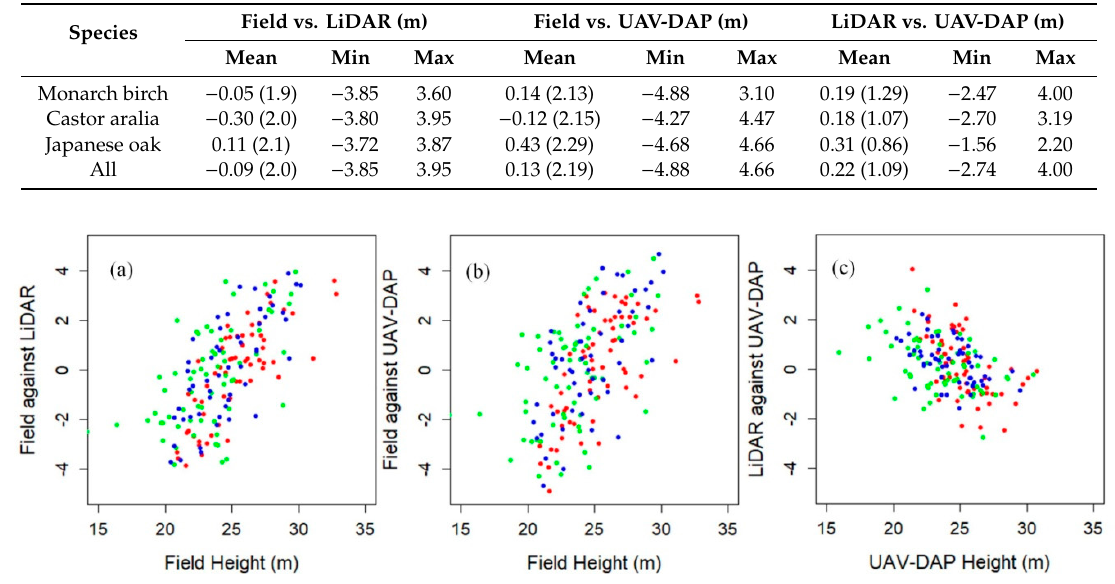
Figure 4. Height differences between measurement methods. ( a ) Difference between field height and LiDAR height, ( b ) Difference between field height and UAV-DAP height, and ( c ) Difference between LiDAR height and UAV-DAP height. Red, green, and blue dots represent individual monarch birch, castor aralia, and Japanese oak tree height respectively.